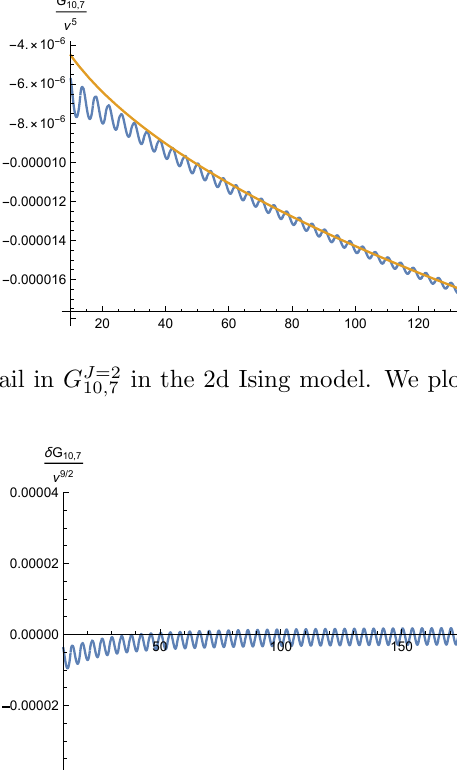
G J =2 ( (cid:23) ) + 2 : 2797910 (cid:0) 8 (cid:23) 5 = 2 10 ; 7 (cid:23) 5